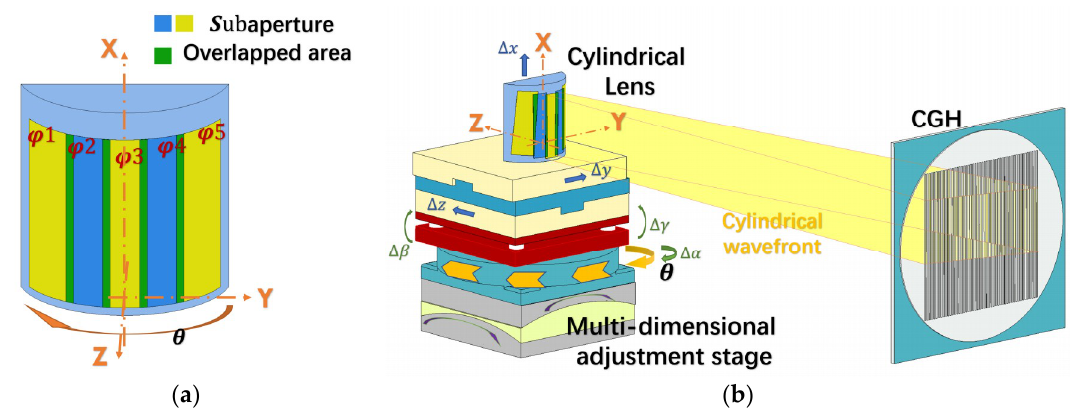
Figure 2. ( a ) Schematic diagram of sub-aperture layout; ( b ) Schematic view of a multi-dimensional adjustment stage.